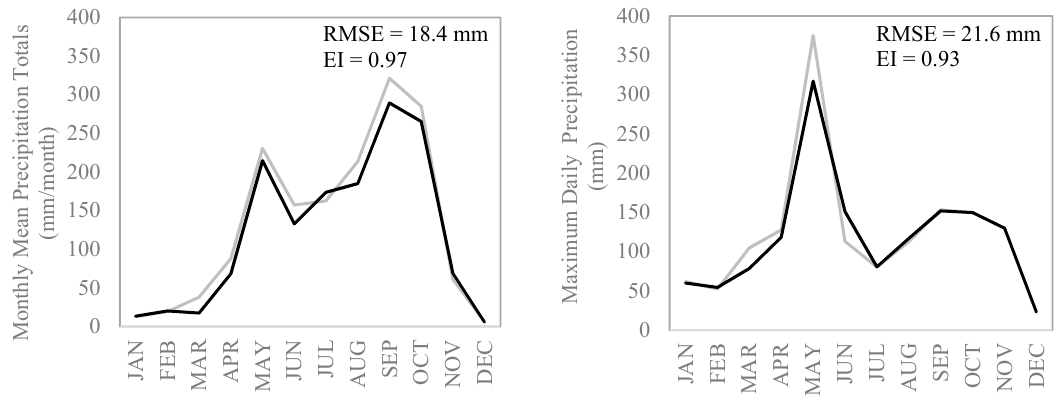
Figure 3. Weather estimation for 1981–2010 (Black: Synthetic, Grey: Observed).